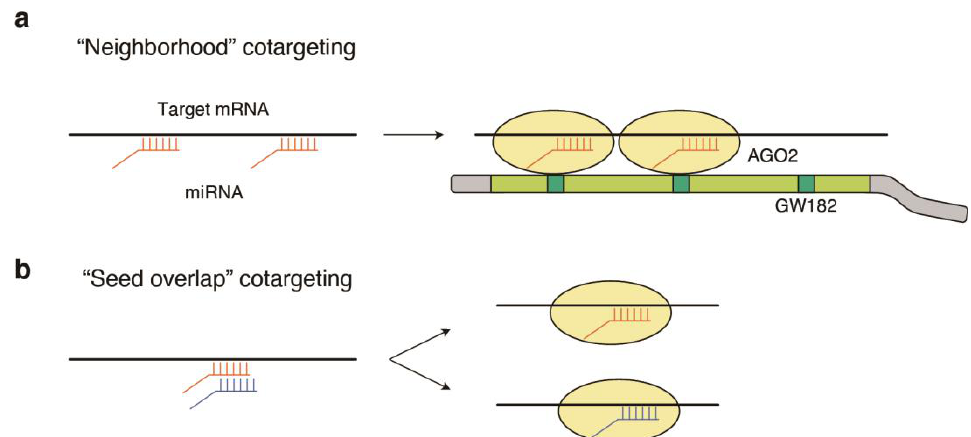
Figure 4. Distinct modes of miRNA cotargeting. ( a ) Closely spaced miRNA target sites can repress target mRNAs cooperatively. The mechanism of this “neighborhood” cotargeting can be explained by multivalent binding of GW182 proteins to multiple miRNA-AGO complexes. ( b ) In addition to “neighborhood” cotargeting, deeply conserved target sites frequently involve “seed overlap” miRNA cotargeting. While “seed overlap” target sites cannot be bound by two miRNAs simultaneously, “seed overlap” miRNA cotargeting increases susceptibility to downregulation by two miRNAs. The miRNA genes with extensive seed overlap are frequently organized in polycistronic clusters and/or distributed at multiple genomic loci.